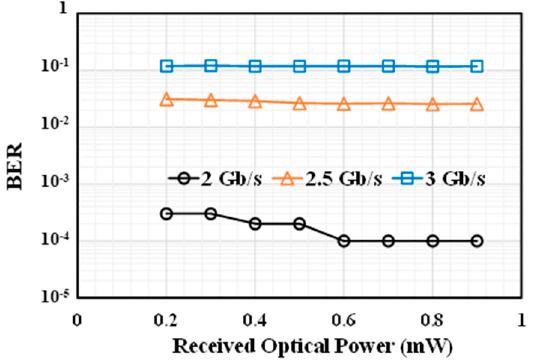
Figure 6. BER vs. received optical power by using SBS detection, the LD bias current is 35 mA and RF voltage is 350 mV.